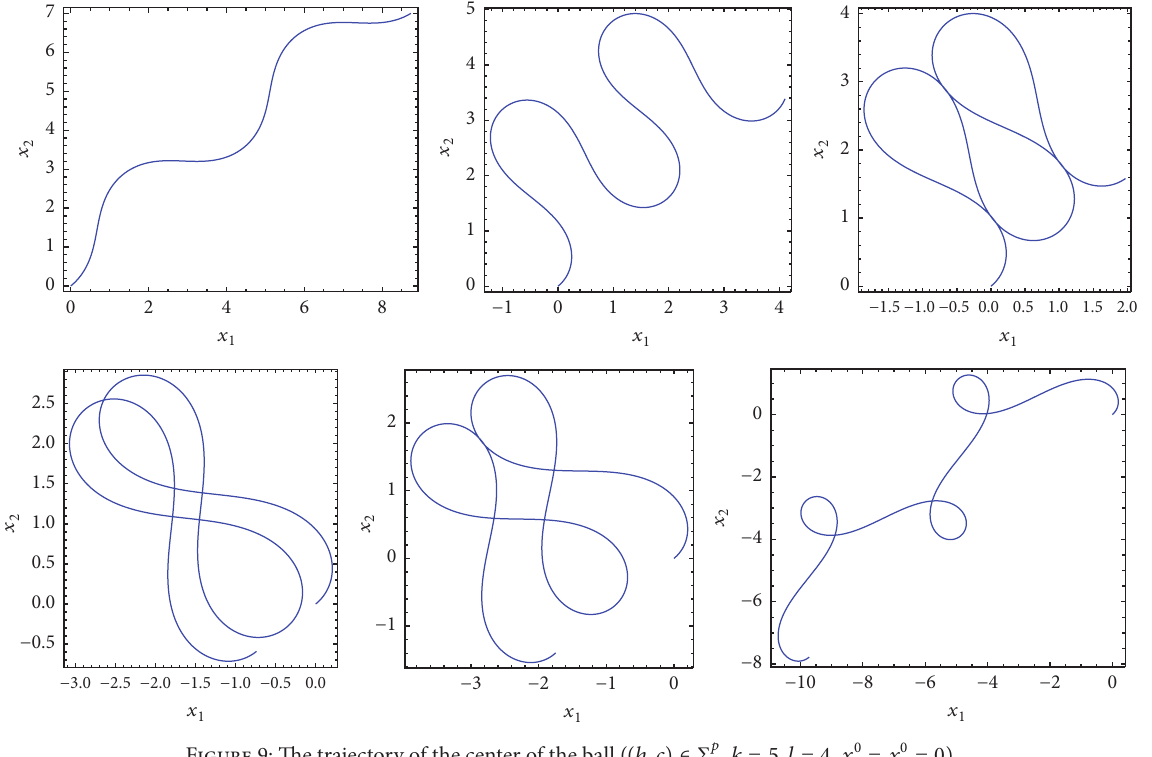
Figure 9: The trajectory of the center of the ball ( (ℎ,𝑐) ∈ Σ 𝑝 2 , 𝑘 = 5 , 𝑙 = 4 , 𝑥 0 1 = 𝑥 0 2 = 0 ).